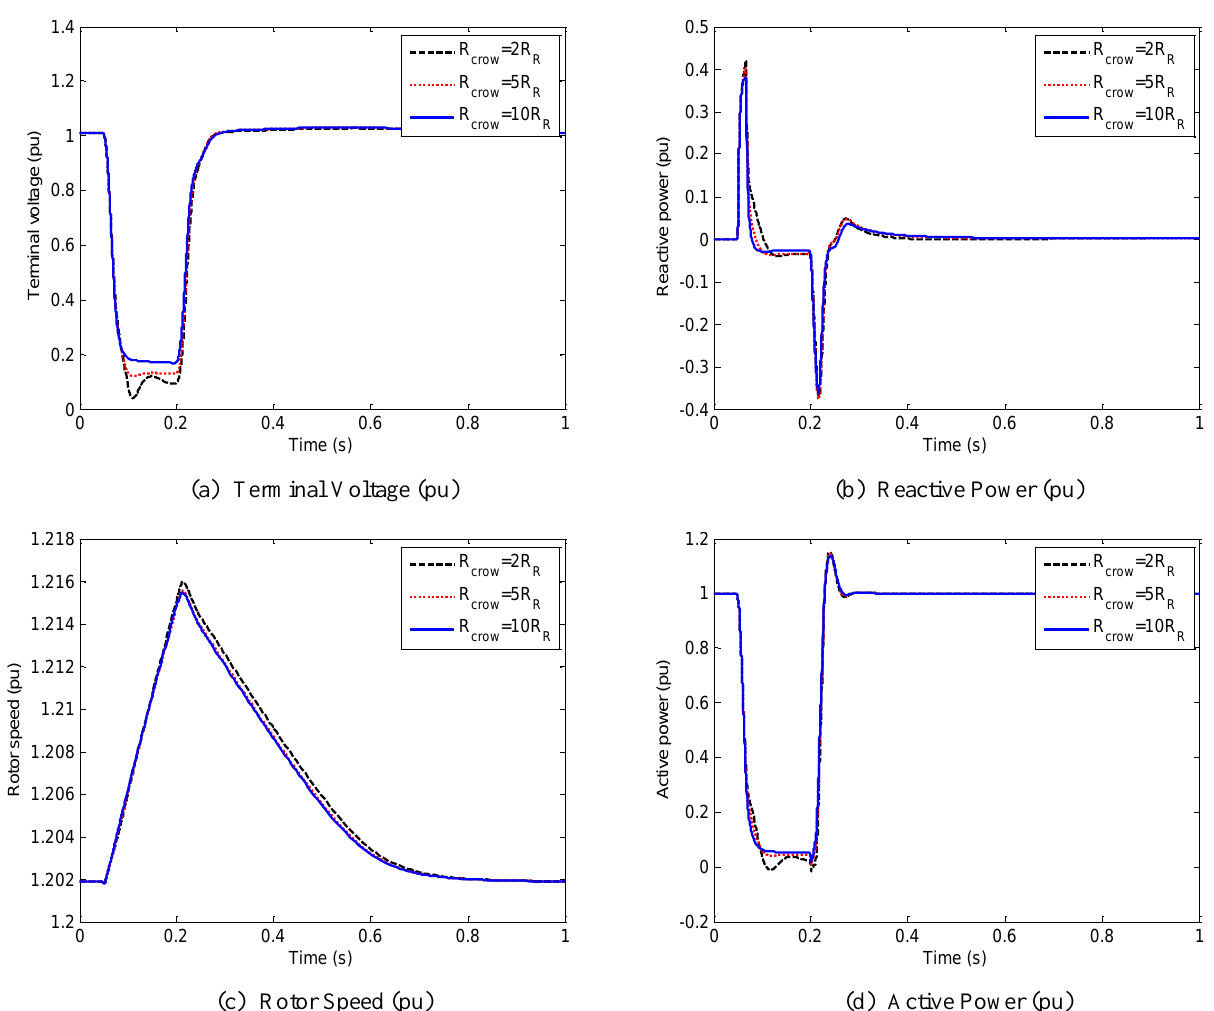
Figure 9. Dynamic analysis of the DFIG for different crowbar resistance value during a fault eliminated in 150 ms at